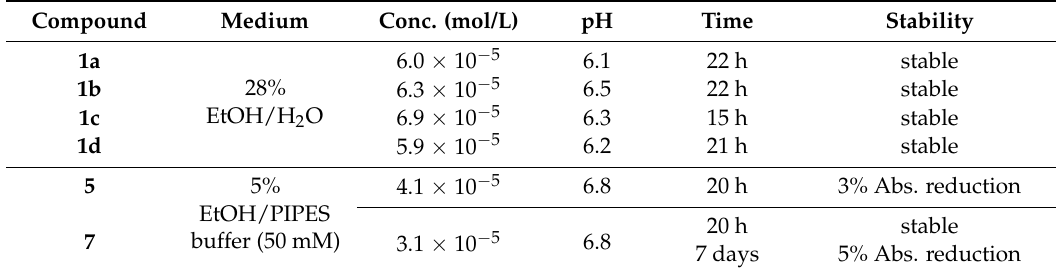
Table 4. Stability study of hydrazones.